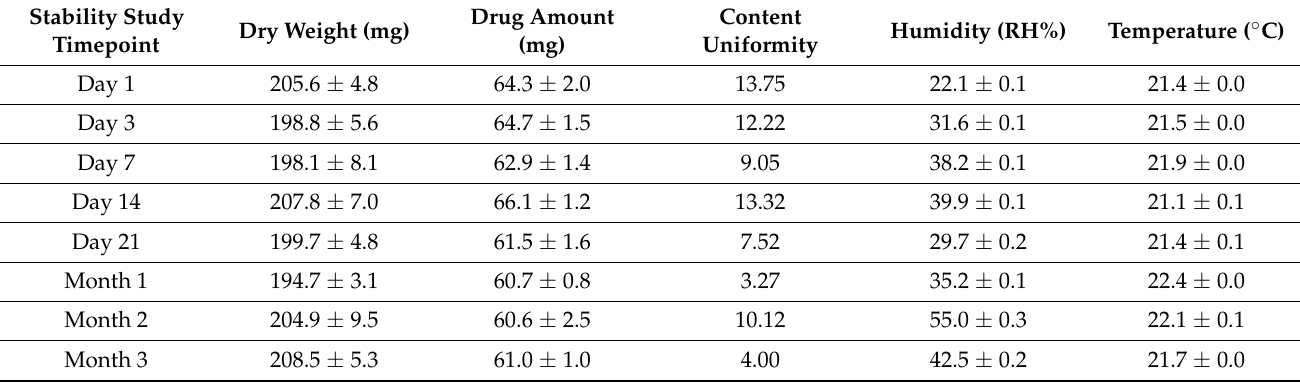
Figure 4. The drug release profile of pure theophylline and theophylline-loaded printed ChewTs in purified water (n = 3). Table 1. Measured average drug content and dry weight with standard deviations and calculated content uniformity (CU) on the pre-determined stability study time points (n = 5). Reported is also the recorded average relative humidity and temperature on each measurement